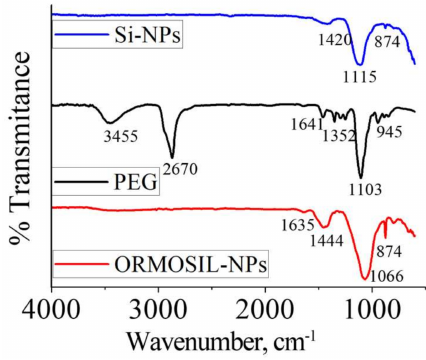
Figure 4. FTIR (Fourier Transform Infrared) spectra of Si-NPs, PEG, and ORMOSIL-NPs.